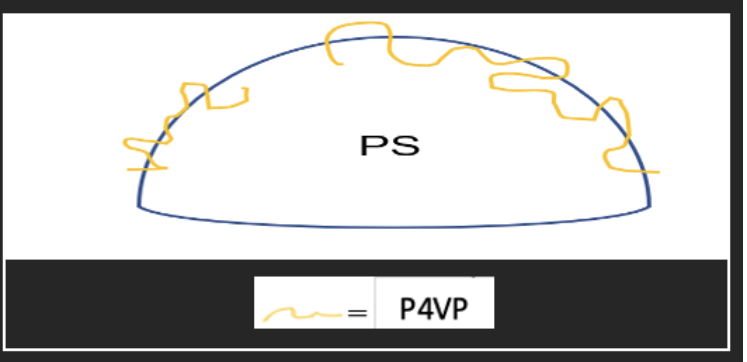
Figure 19. Schematic of PS-co-P4VP with P4VP (poly(4-vinylpyridine)) on the surface.